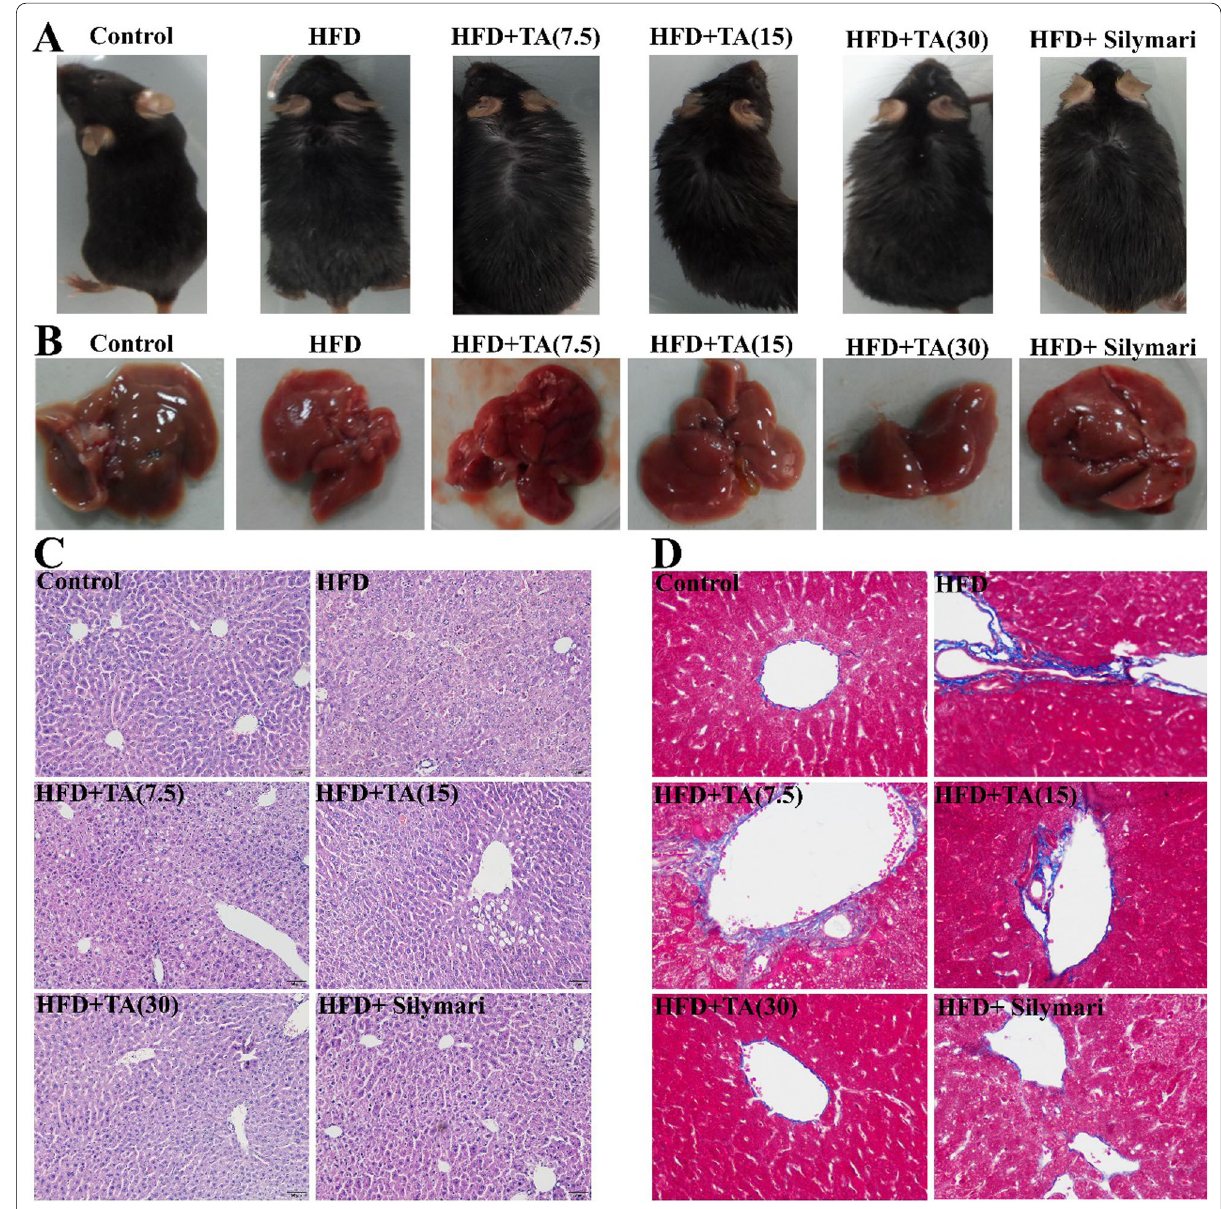
Fig. 2 Effect of TA on general observation and histopathologic examination . A general observation of mice and livers ( B ), HE ( C ) and Masson ( D ) staining of liver tissues . Control: mice were fed anormal diet and treated with 0.5%CMC‑Na (solvent) via gavage; HFD: mice were fed HFD; HFD (7.5), HFD TA (15), and HFD TA (30) mice were fed a HFD and treated with TA (7.5, 15, and 30 mg/kg, respectively) via gavage; HFD + + mice were fed HFD and treated with silymarin via